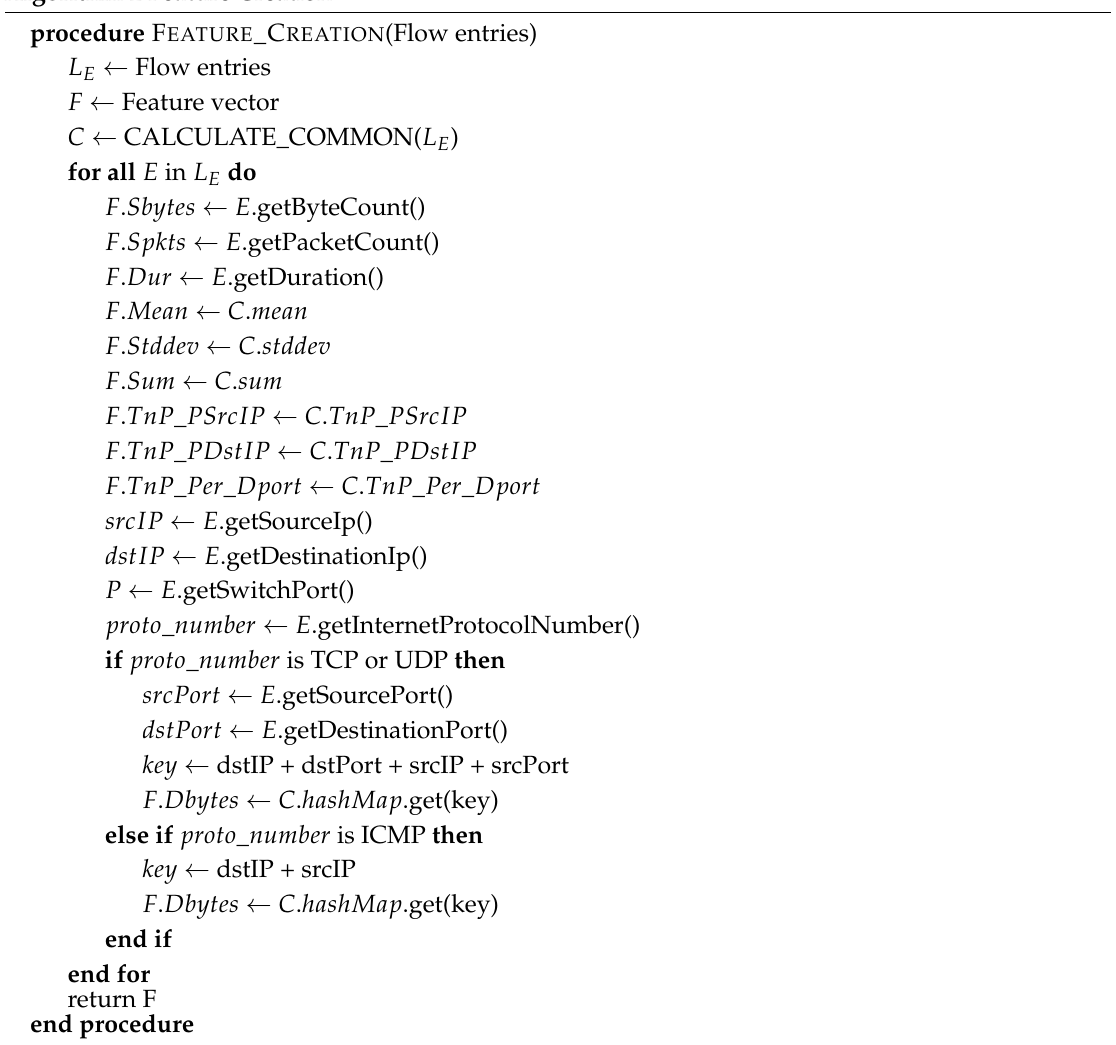
Algorithm 2 Feature